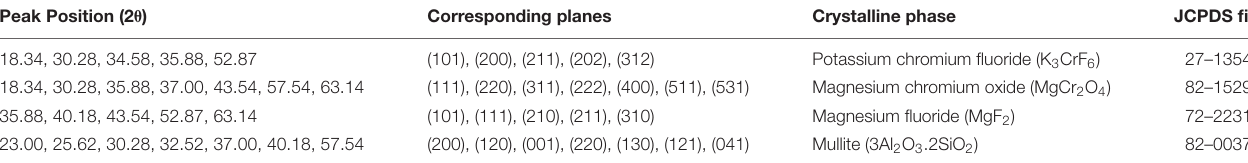
TABLE 3 | XRD peaks and corresponding planes of different crystalline phases developed in K 2 Cr 2 O 7 -containing K 2 O-MgO-Al 2 O 3 -B 2 O 3 -SiO 2 -F glasses. Peak Position (2 θ ) Corresponding planes Crystalline phase